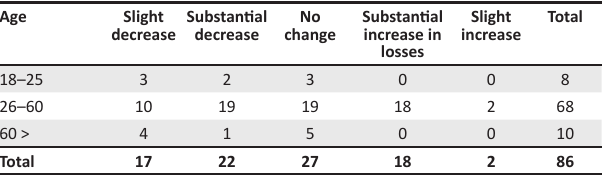
TABLE 9: Changes in disaster loss per age group.